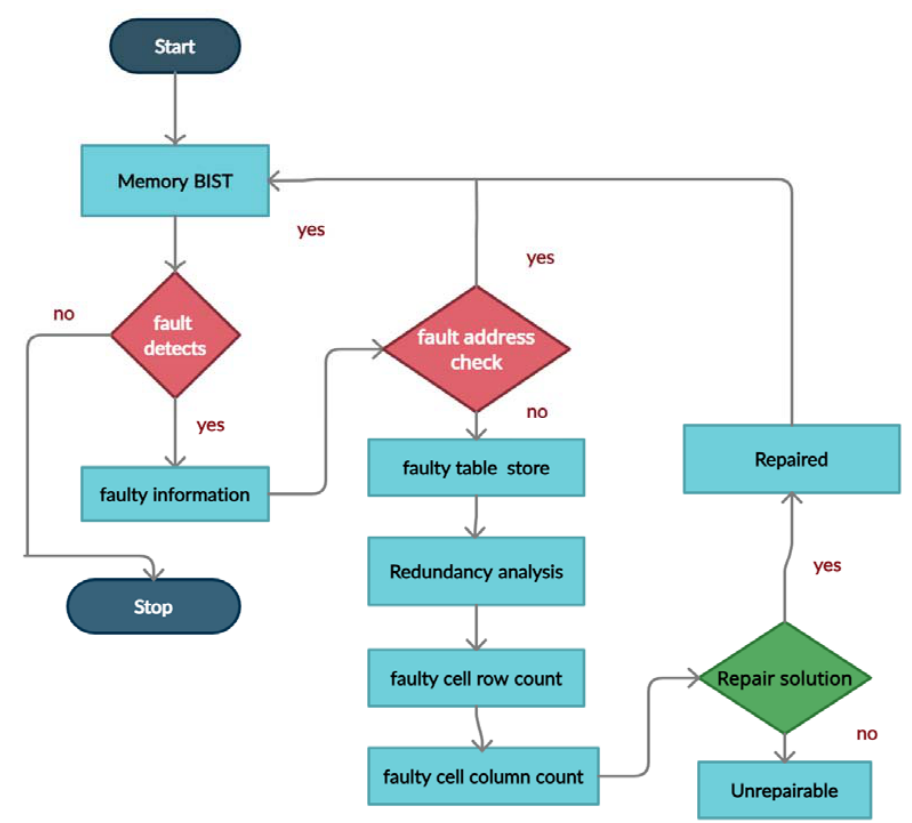
Figure 4. The built-in self-repair (BISR) operational flow. Figure 4. The built ‐ in self ‐ repair (BISR) operational flow.